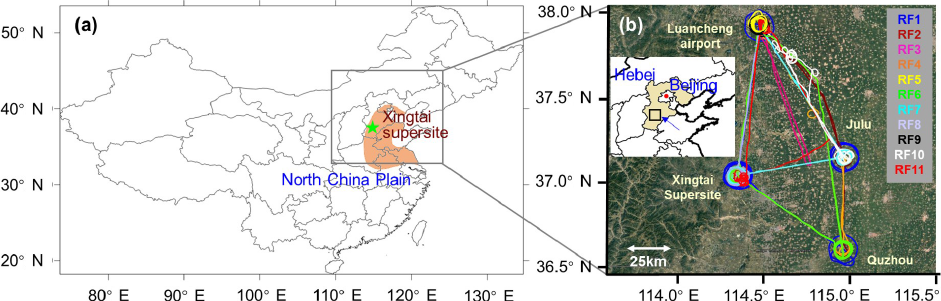
Figure 1. Map of the geographic location of the North China Plain and the Xingtai supersite (a) , and the flight tracks of the 11 research flights conducted over Hebei Province during May–June 2016 (b) . The orange shaded area denotes the North China Plain.